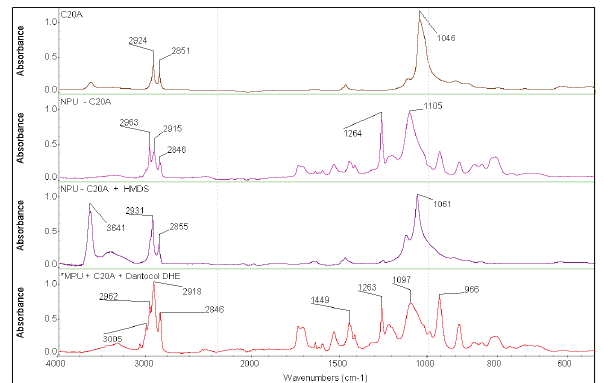
Figure 2: FT-IR spectra for three HTPB-based nanocomposites (NPU). Top to bottom: nanoclay C20A (a), NPU with C20A nanoclay (b), NPU with C20A plus hexamethylene disilazane (HMDS) (c) and NPU with C20A plus Dantocol DHE